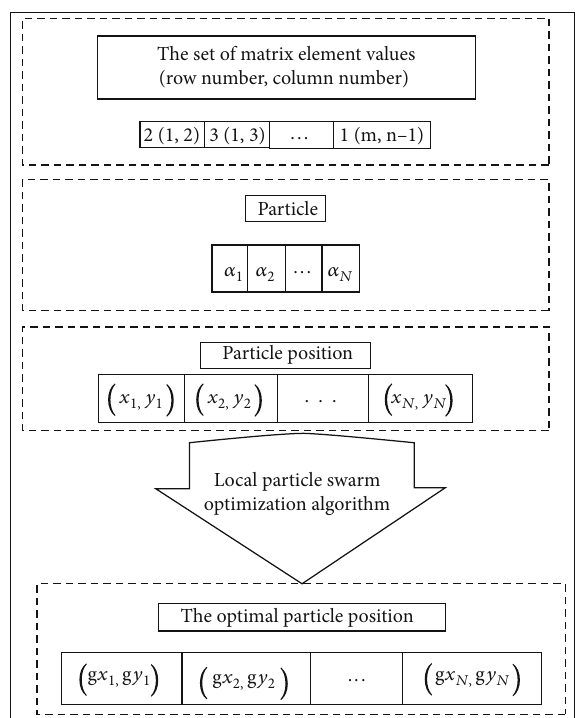
Figure 2: Schematic diagram of the PSO landscape pattern spatial optimization